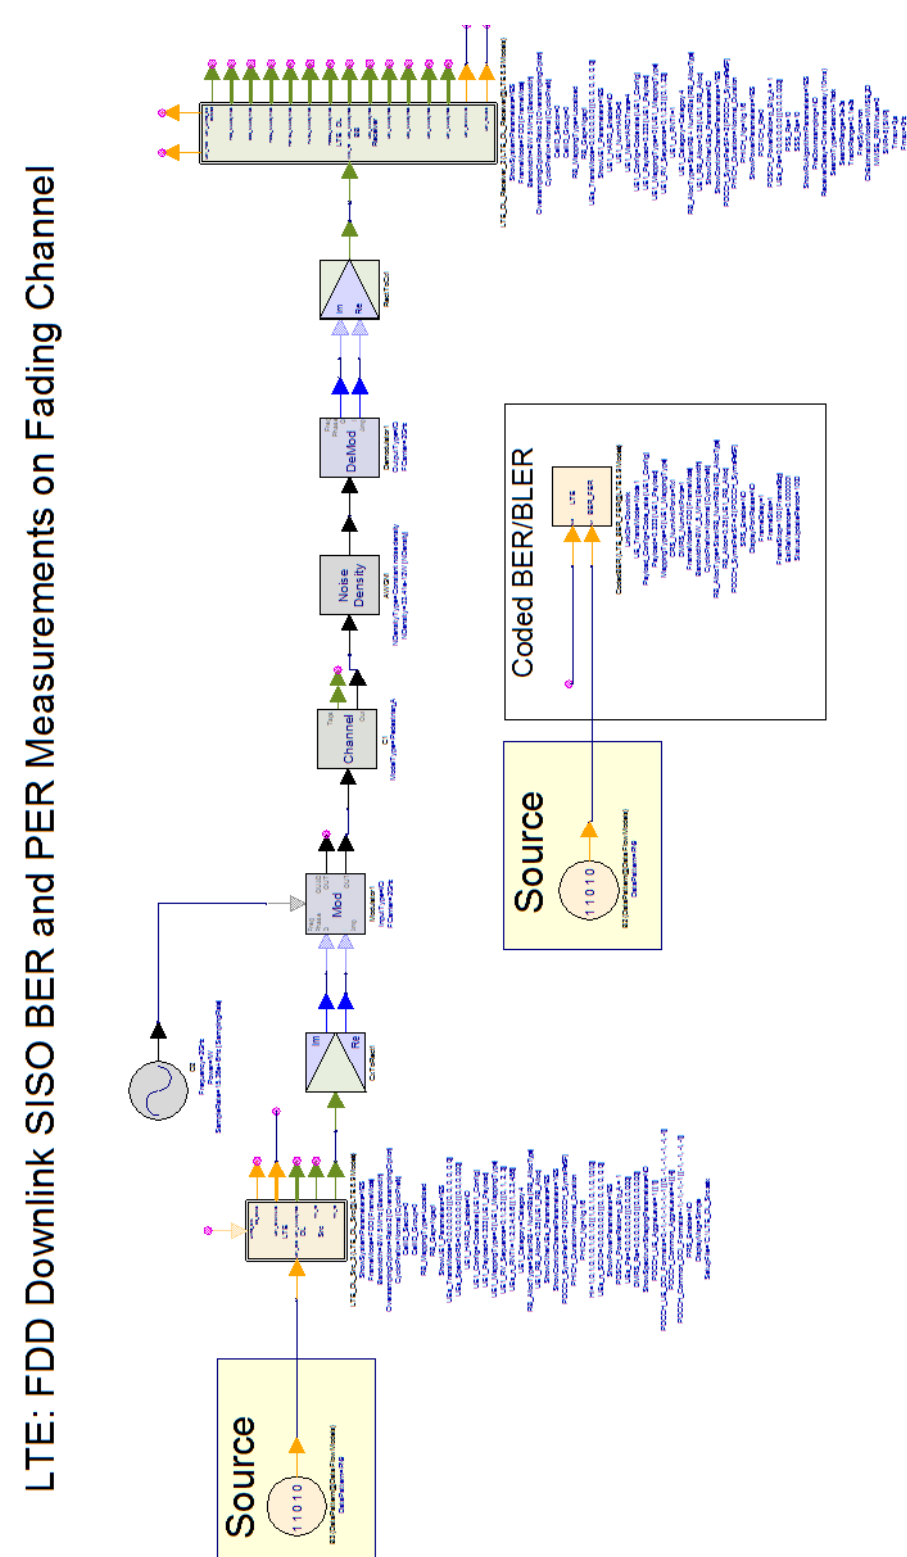
Figure 3. Long-Term Evolution (LTE) FDD downlink BER simulator setup.